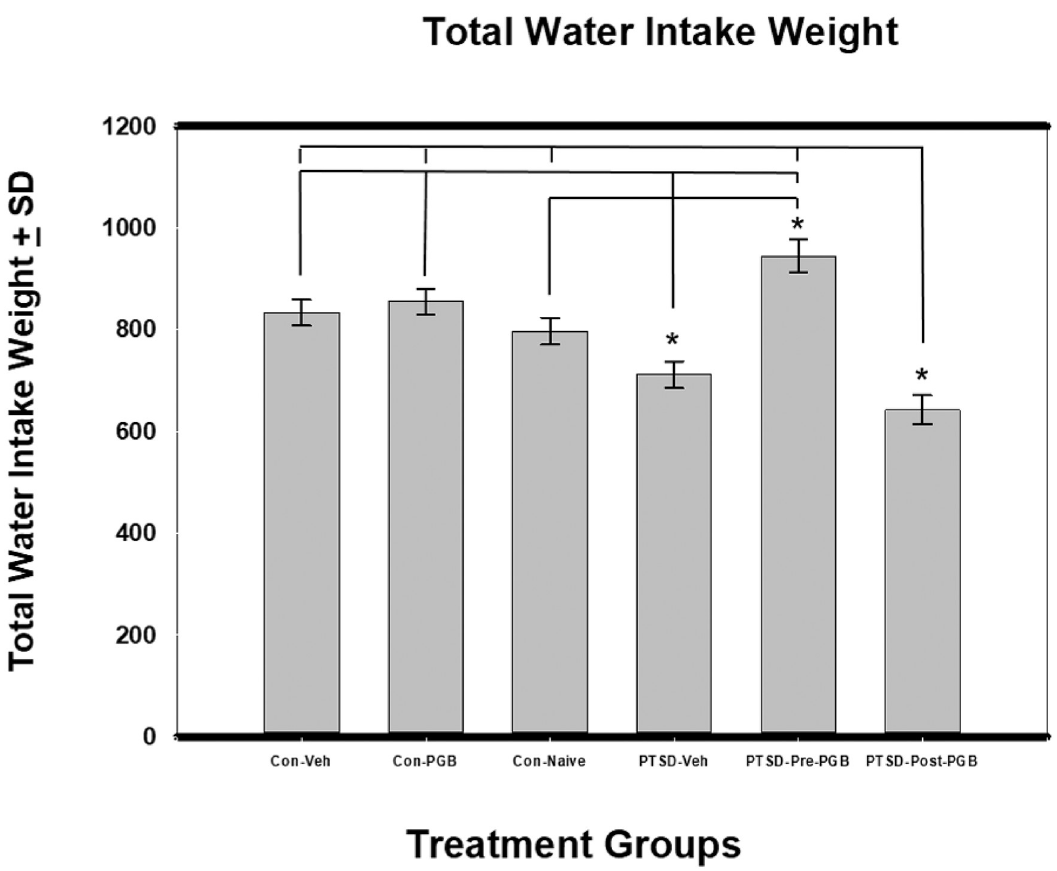
Fig 2. ANCOVA for total water intake weight. Each of the main two groups (Stressed and Non-stressed) had three subgroups: non-stressed: control vehicle, control PGB, control na ï ve; and stressed: Posttraumatic stress disorder (PTSD) vehicle, PTSD Pre-PGB (prophylactic), PTSD Post-PGB (non-prophylactic). Mean total water intake weight is reported with the SEM. Asterisks denote statistical significance at p < .05. PTSD-Post-PGB was significantly less than PTSD-Pre-PGB and all three control groups. PTSD Veh was significantly lower than Con-Veh, Con-PGB, and PTSD-Pre-PGB. PTSD-Pre-PGB was significantly higher than Con-Na ï